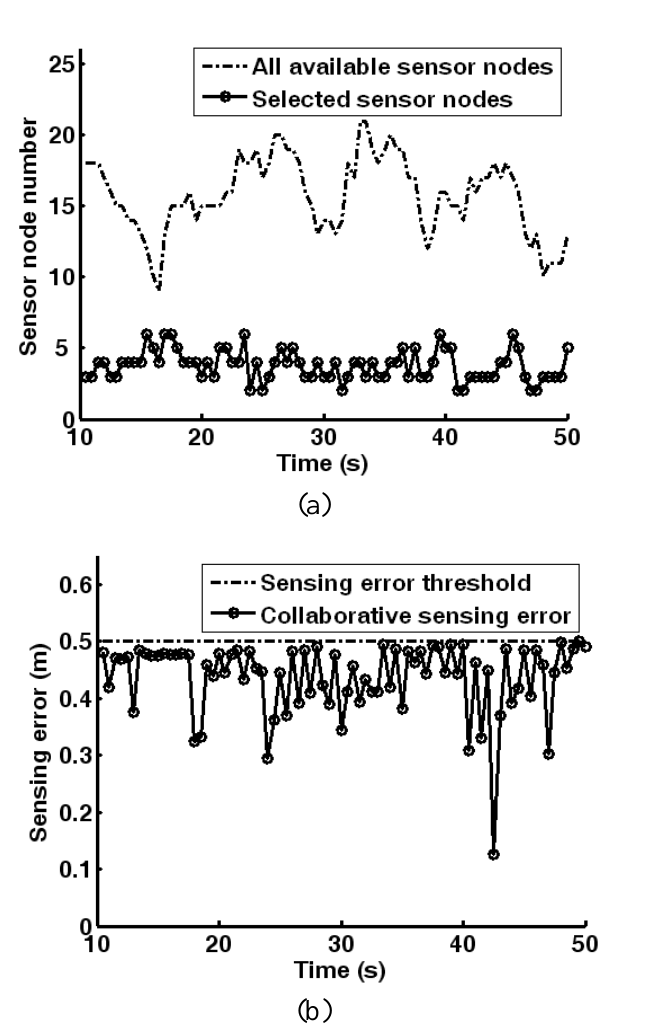
Figure 11. Sensor node selection optimization results by BPSO: (a) selected sensor node number; (b) collaborative sensing error.